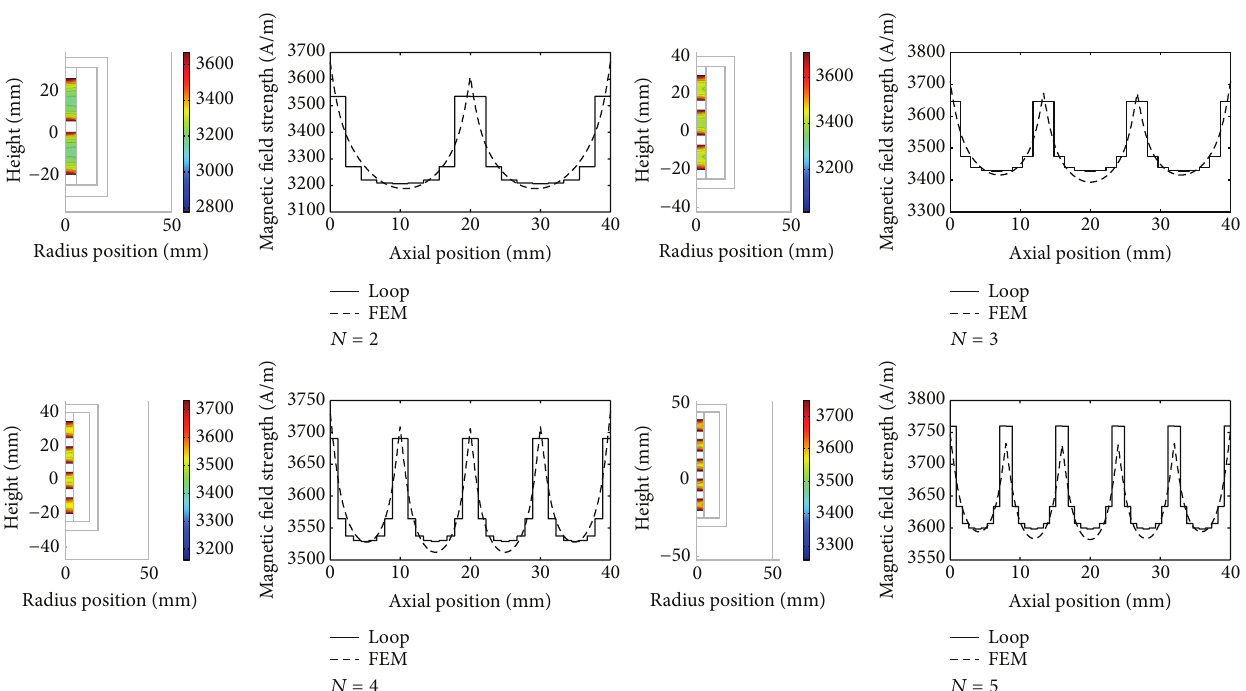
Figure 10: Magnetic field contour in GMM domain and axial distribution comparison with loop